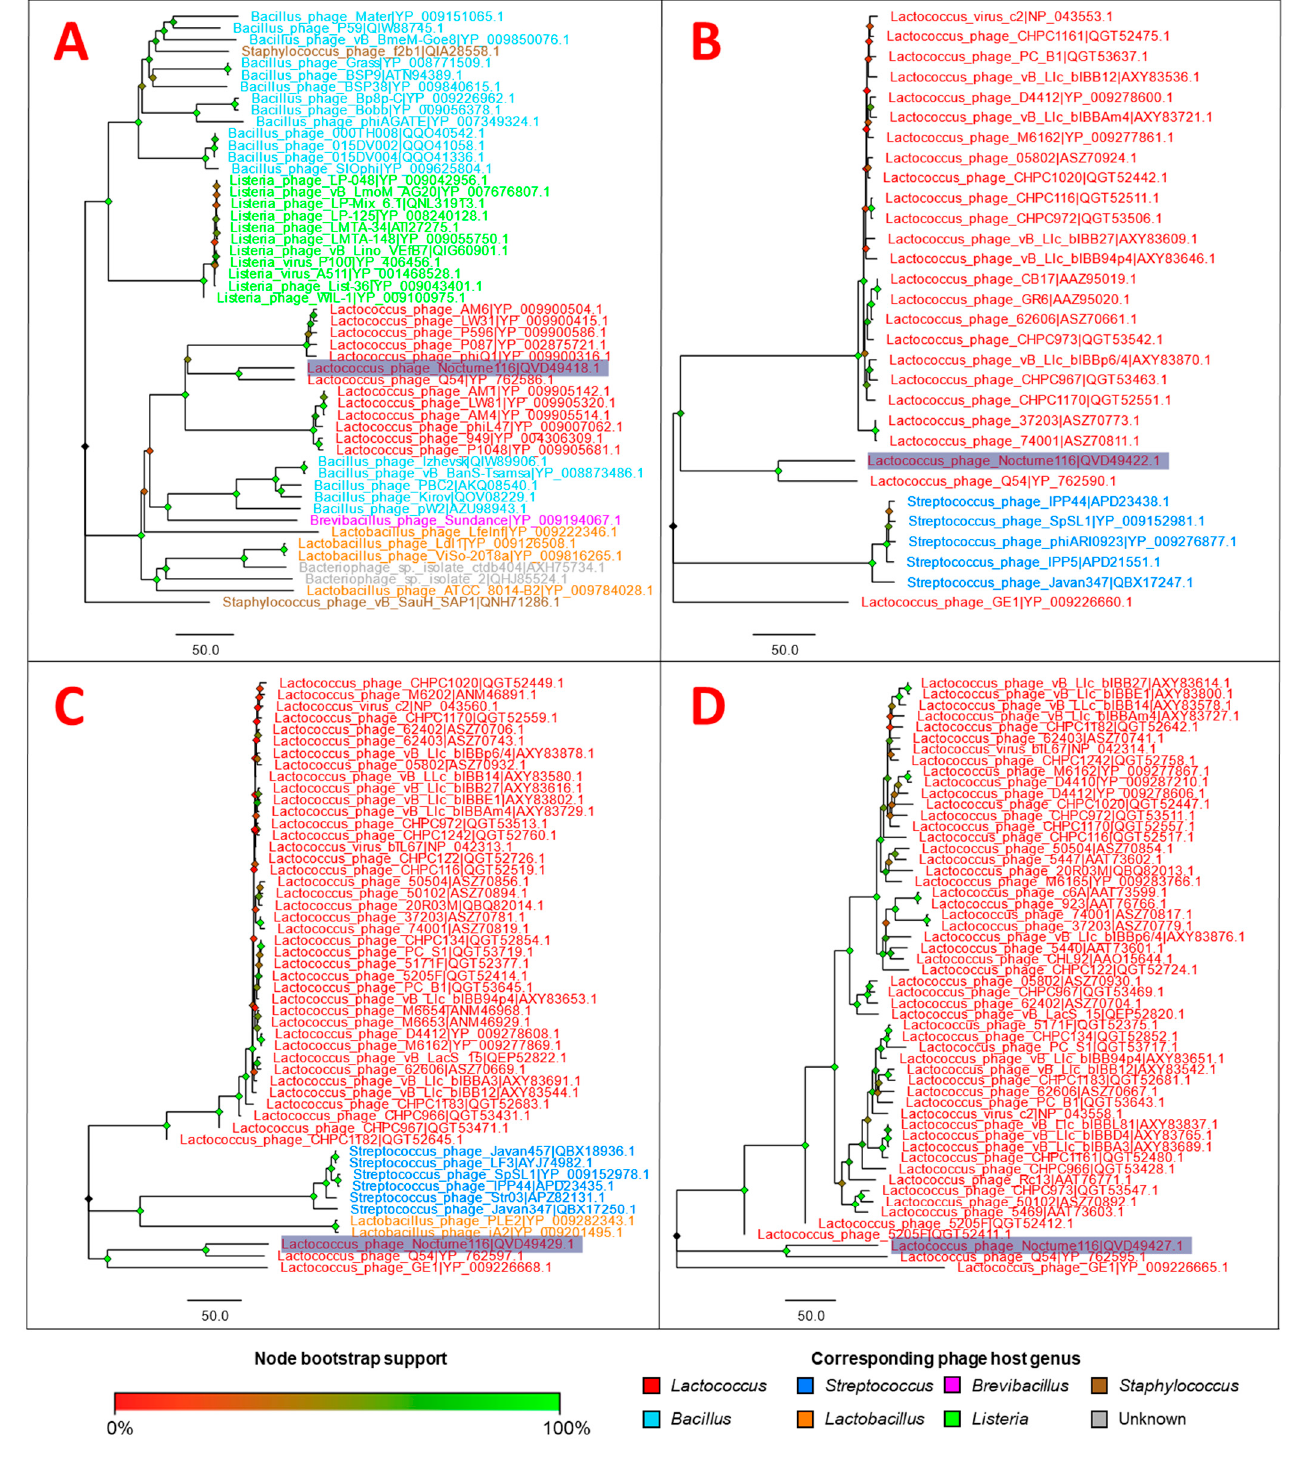
Figure 2. Neighbor-joining (NJ) trees of the selected Nocturne116 protein amino acid sequences and similar sequences found in the proteomes of other phages. The trees are drawn to scale and branch lengths correspond to the number of amino acid differences. For each ClustalW-generated [33] multiple sequence alignment used to build the NJ trees [34], all positions with less than 90% site coverage were eliminated (less than 10% alignment gaps, missing data, and ambiguous bases were allowed at any position). ( A ) putative DNA polymerase (51 sequences with 393 aa positions in the final dataset; the optimal tree with the sum of branch lengths = 2245.23899841 is shown); ( B ) major capsid protein (30 sequences with 394 aa positions in the final dataset; the optimal tree with the sum of branch lengths = 836.47900391 is shown); ( C ) terminase (51 sequences with 507 aa positions in the final dataset; the optimal tree with the sum of branch lengths = 1099.23297322 is shown); ( D ) tail tape measure (54 sequences with 619 aa positions in the final